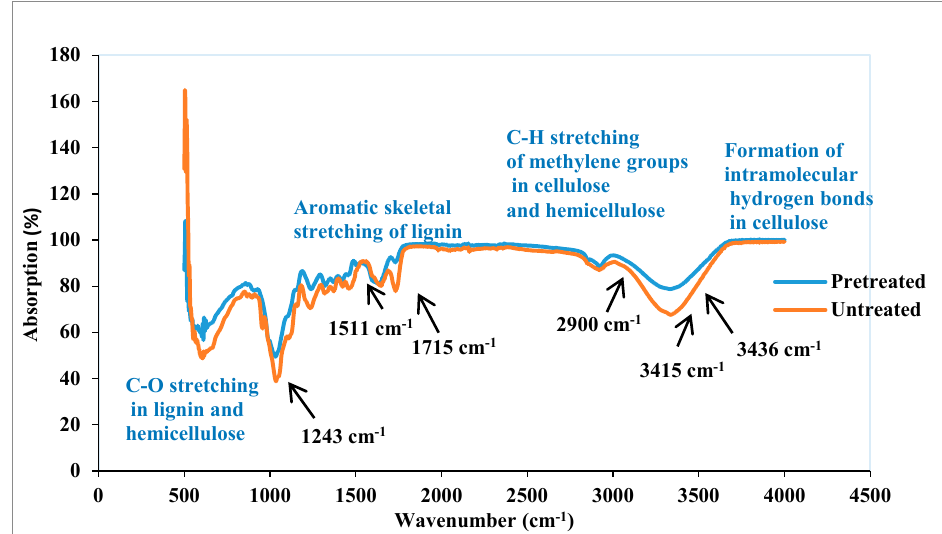
Figure 4. FT-IR spectrum of ChCl: LA pretreated and raw Atriplex crassifolia.